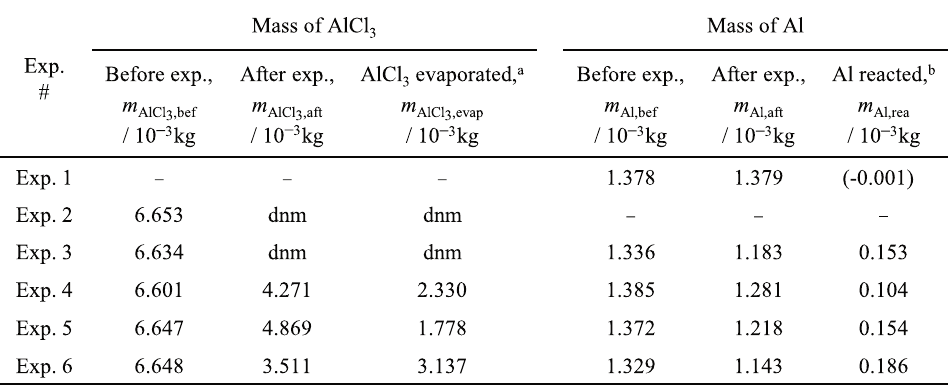
Table 5. Sample mass before and after the experiments.